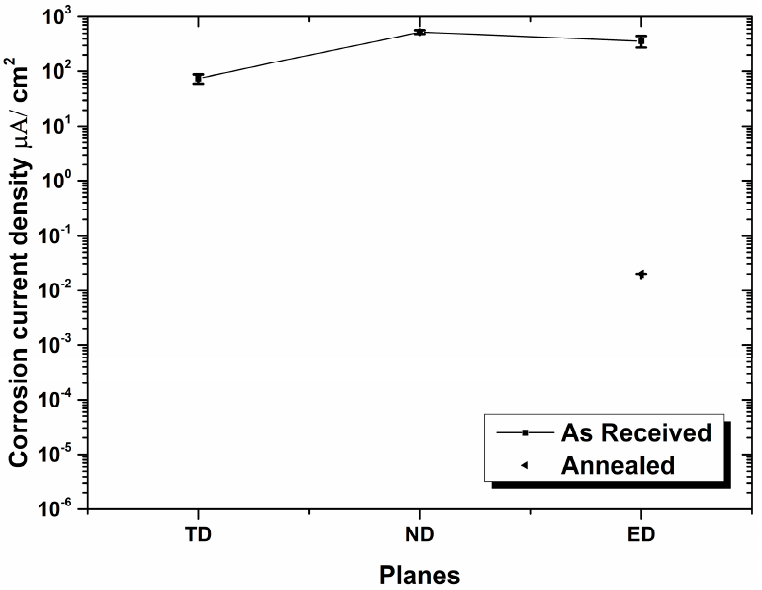
Figure 5. Comparison of corrosion current density of the heat-treated (450 °C/1 h) ED (i.e., ED + HT) with TD, ND and ED alloy in 3.5 wt% NaCl. Error bars are the standard deviation of the replicated measurements.